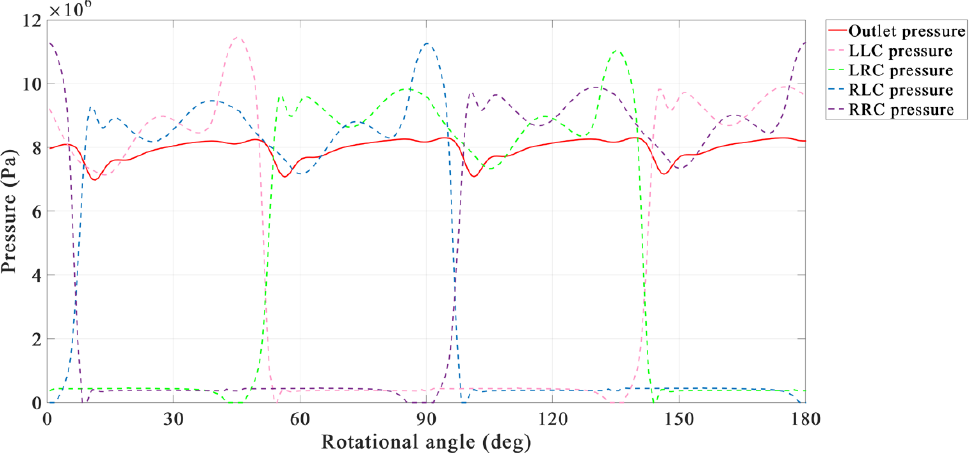
Figure 16. The outlet pressure of the parallel 2D piston pump.